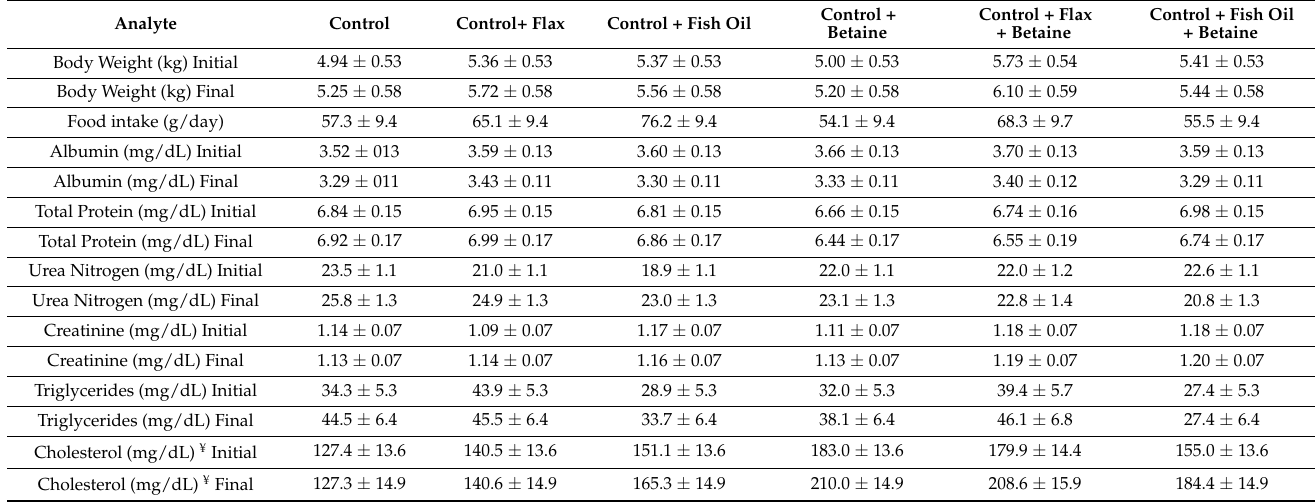
Table 2. Body weight and selected serum biochemistries from serum biochemical profiles (values are lsmeans ± standard